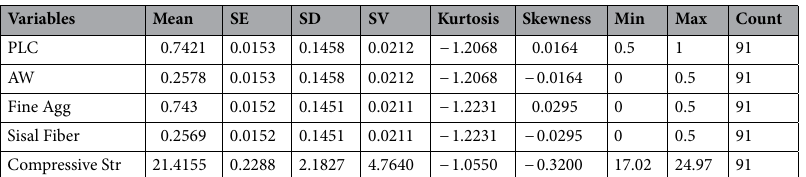
Table 5. Statistical parameters of system datasets for the model development. SE standard error; SD standard deviation; SV sample